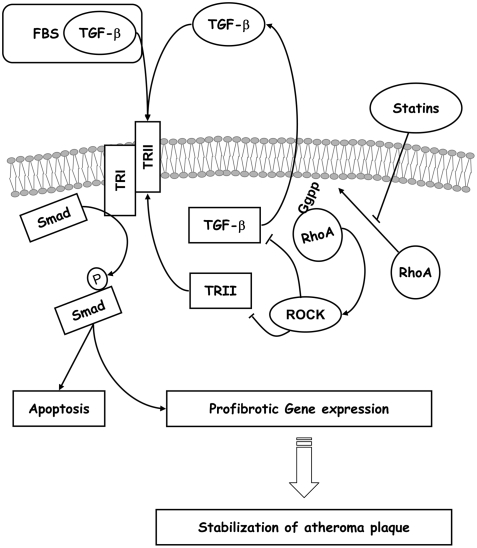
Model for statin action.Proposed model for statin interaction with the TGF-β/Smad pathway in atherosclerosis. In normal conditions TRII and TGF-β expression is regulated by RhoA through ROCK activation. Hyperactivation of RhoA in pathological condition may lead to the downregulation of TRII and TGF-β that characterizes unstable plaques. Statins inhibit prenylation of RhoA, thus increasing TRII expression and TGF- β release. The TRII upregulation allows TGF-β present in serum or induced by statins to activate the Smad pathway and increase ECM proteins production. These effects may promote plaque stability.